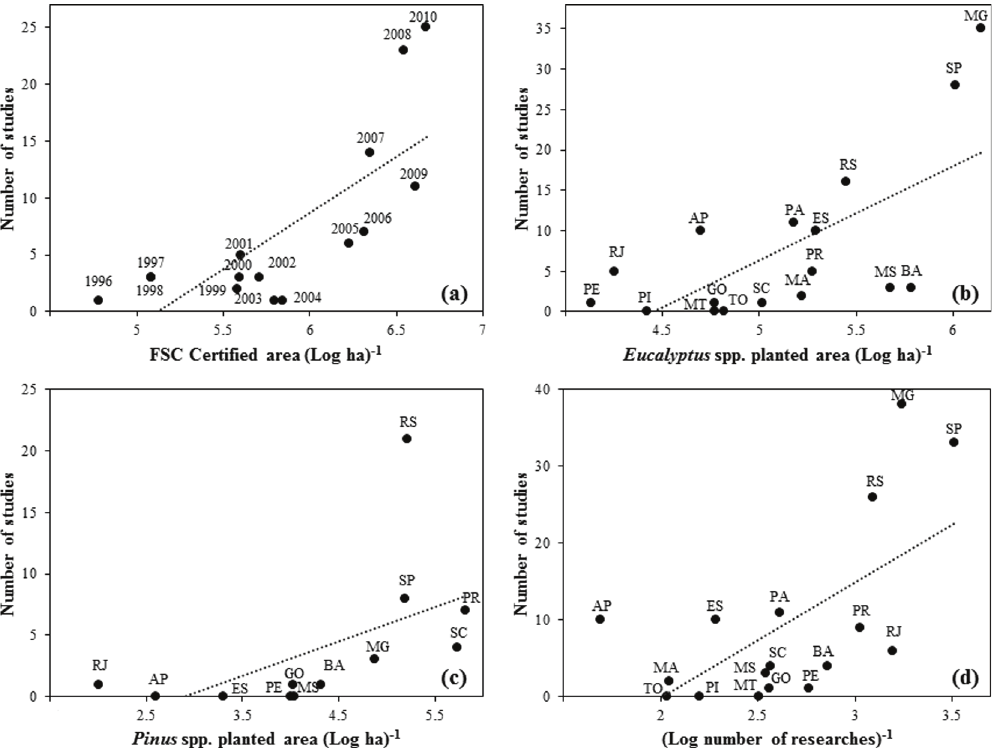
figure 3 - Correlations (a) between number of studies and increase in number of FSC certified areas, (b) between number of studies and area planted with Eucalyptus spp. in each Brazilian State, (c) between number of studies and area planted with Pinus spp. each Brazilian State, and (d) between number of studies and number of researchers in each Brazilian State. Dotted lines indicate the lines of best fit. AP = Amapá; BA = Bahia; ES = Espírito Santo; GO = Goiás; MA = Maranhão; MG = Minas Gerais; MS = Mato Grosso do Sul; MT = Mato Grosso; PA = Pará; PE = Pernambuco; PI = Piauí; PR = Paraná; RJ = Rio de Janeiro; RS = Rio Grande do Sul; SC = Santa Catarina; SP = São Paulo; TO =